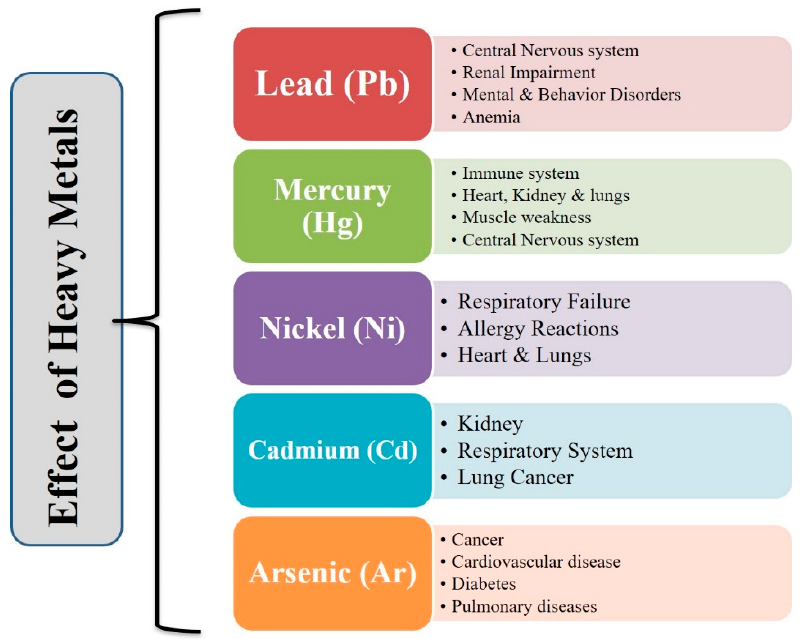
Figure 2. Effects of heavy metals on the health of living systems.